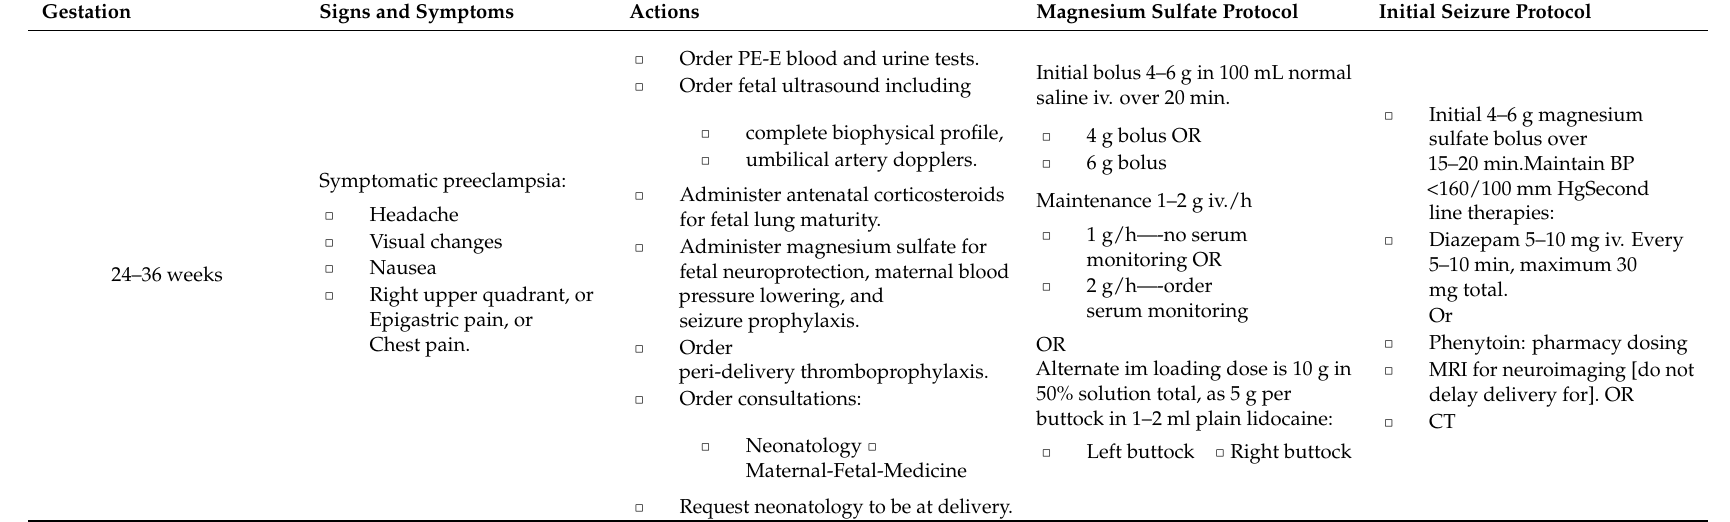
( B ) Second and third trimester